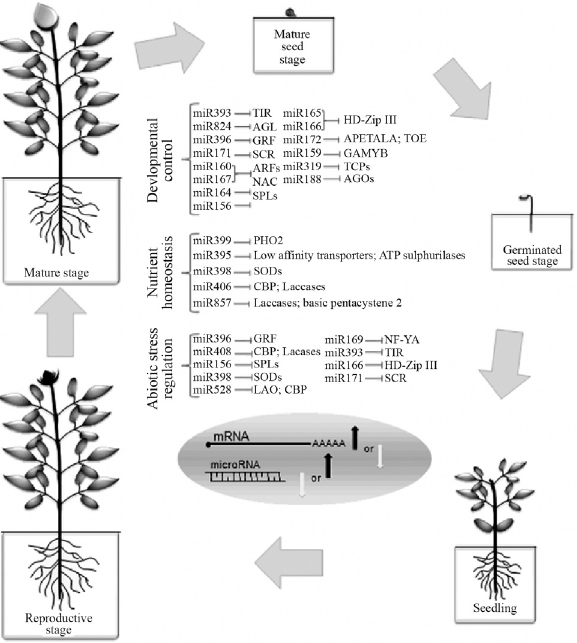
Figure 2 - Mature miRNAs act in plant development, in response to abioticstresses,andalsointhecontrolofnutrienthomeostasis.Depending on the plant species, the miRNA/target genes are modulated differently in thesamebiologicalconditions.OnlymiRNAtargetsalreadyconfirmedby expression analysis and/or degradome sequencing were included in this diagram. TIR: F-box protein; AGL: agamous like; GRF: growth